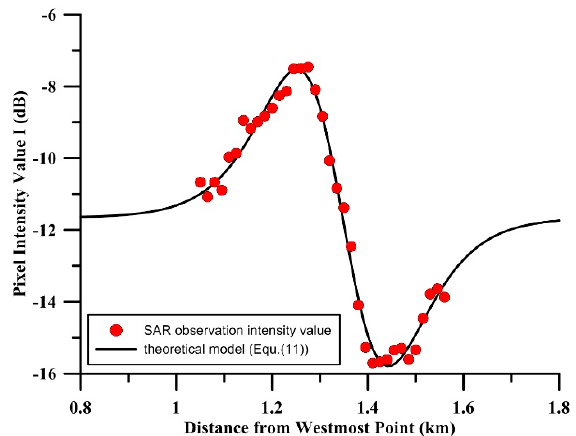
Figure 7. Curve fittings of the theoretical model (Equation (11)) (the black line) to the pixel observation intensity value (red point) of the soliton L 1 along transect AA’ in Figure 2a.